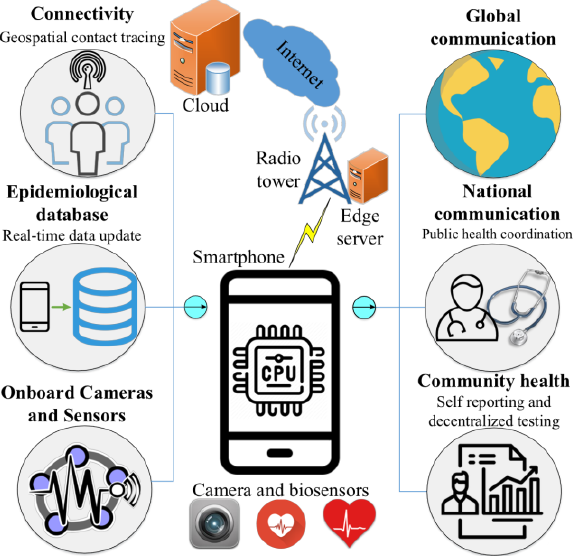
Figure 25. An AI-based framework using mobile phones for COVID-19 diagnosis and surveillance [104].